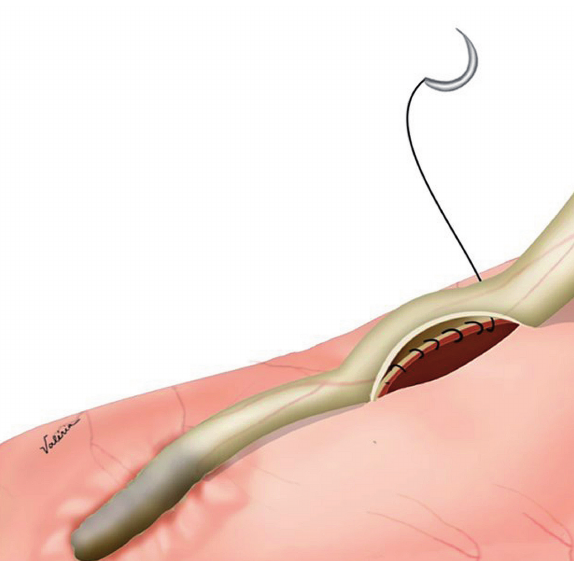
figure 2 - Anastomosis in urinary